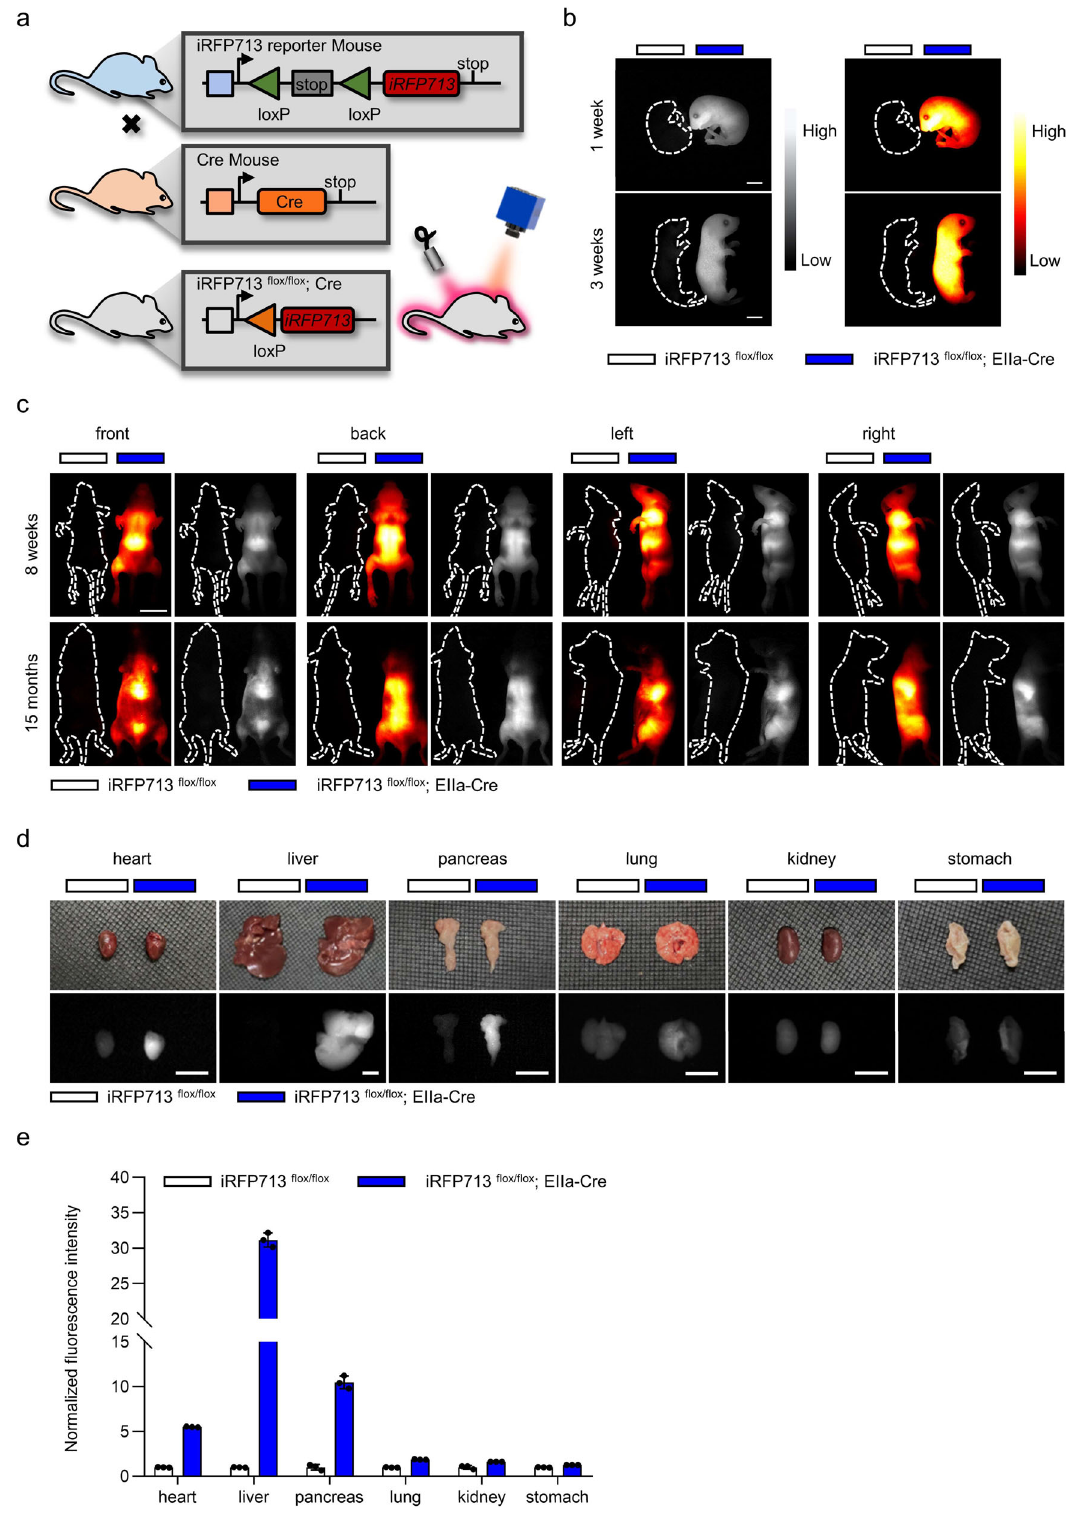
fl uorescence images of major organs isolated from both mice provided in c . e Normalized fl uorescence intensities of organs shown in d . Data presented as mean values±SEM, n =3 mice for each group. Images were acquired with 690nm excitation and 900nm LP emission fi lters. Exposure times: 35ms ( b, c ) and 20ms ( d ). Scale bars: 1cm ( b ), 2cm ( c ) and 5mm ( d ).